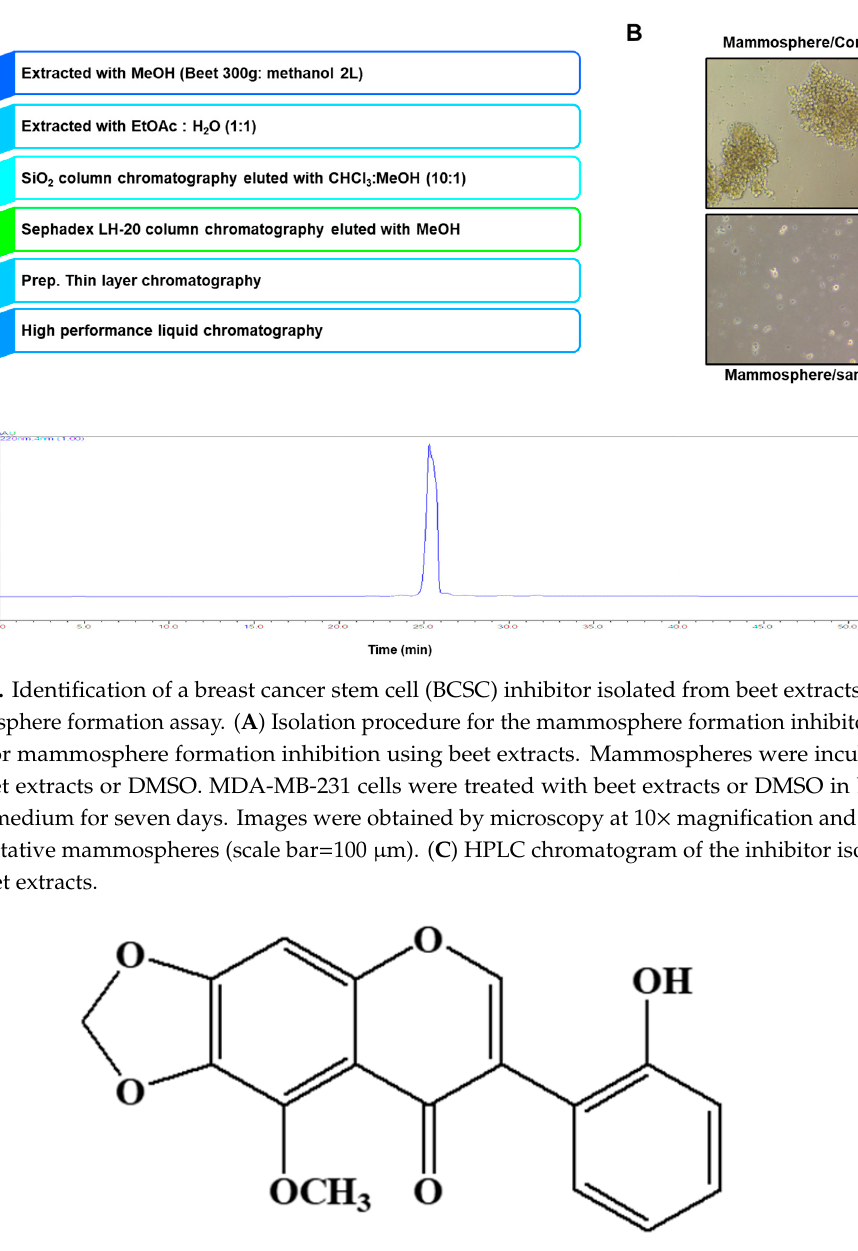
Figure 1. Identification of a breast cancer stem cell (BCSC) inhibitor isolated from beet extracts via a mammosphere formation assay. ( A ) Isolation procedure for the mammosphere formation inhibitor.